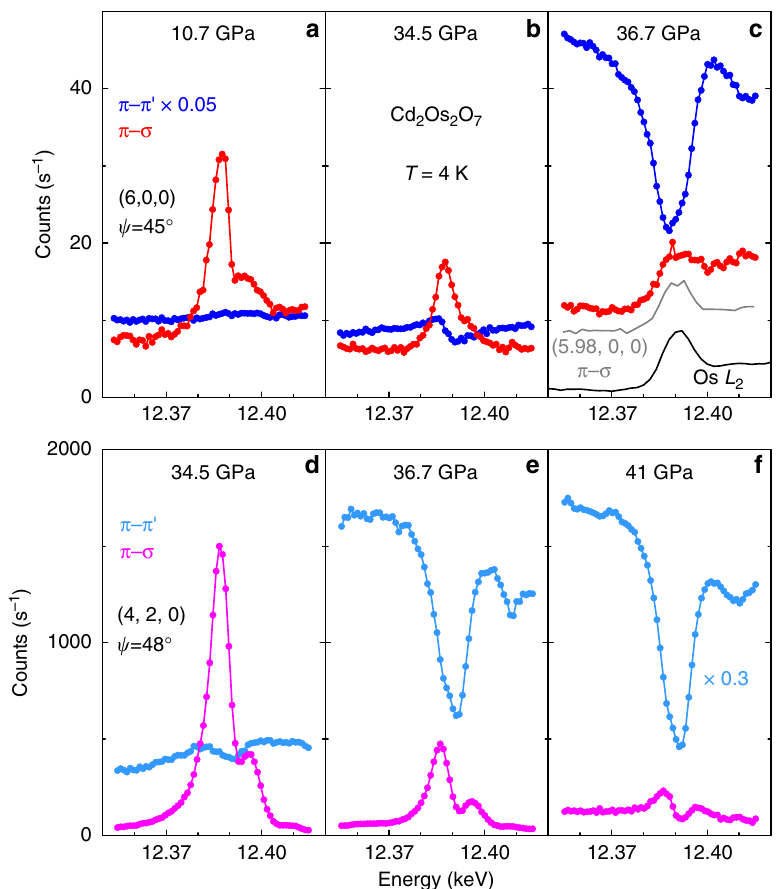
Fig. 4 Polarization-sensitive resonant diffraction data under pressure. Raw energy scan pro fi les at both ( a – c ) (6, 0, 0) and ( d – f ) (4, 2, 0) orders from two separate polarization channels ( π – σ in red/pink and π – π ’ in navy/aqua solid circles), expressed in counts s − 1 for 100 mA synchrotron storage ring current. The azimuthal angel ψ relative to the (0, 0, 1) vector is speci fi ed for each order. At (6, 0, 0), the π – σ channel manifests magnetic resonant spectra whose intensity decreases continuously with pressure. Beyond 36 GPa ( c ), the sharp resonance disappears, and a background similar to the Os L 2 absorption edge shape remains, which comes from X-ray fl uorescence that passed through the polarization analyzer. Its origin is demonstrated by a comparison with an energy scan at (5.98, 0, 0) (gray line, c ), where no magnetic diffraction is expected, and also with an Os L 2 absorption spectrum at 39.3 GPa (black line, c ). The fl uorescence part of the background intensity is dependent on the detector slit size. At (4, 2, 0), the π – σ channel reveals the orbital ordering via the anisotropic tensor susceptibility resonance. For both (6, 0, 0) and (4, 2, 0) orders, the π - π ’ charge diffraction intensities rise dramatically at pressures above the magnetic phase boundary, with a small leakage into the π - σ channel becoming apparent in f through the polarization analyzer